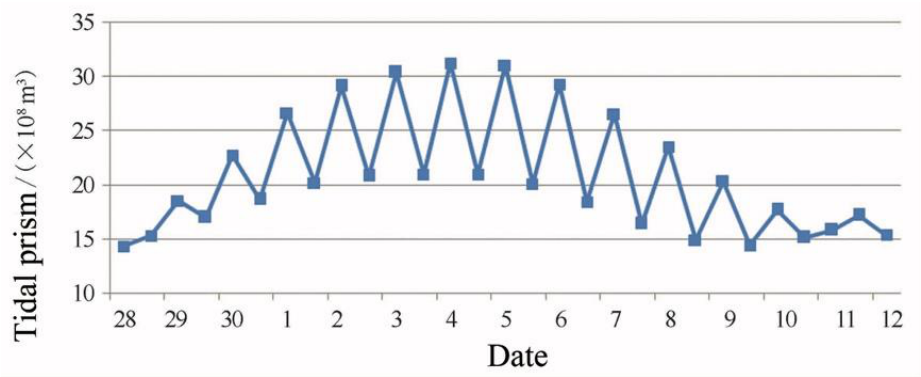
Figure 8. Tidal prism changing process (28 November 2009 to 12 December 2009).